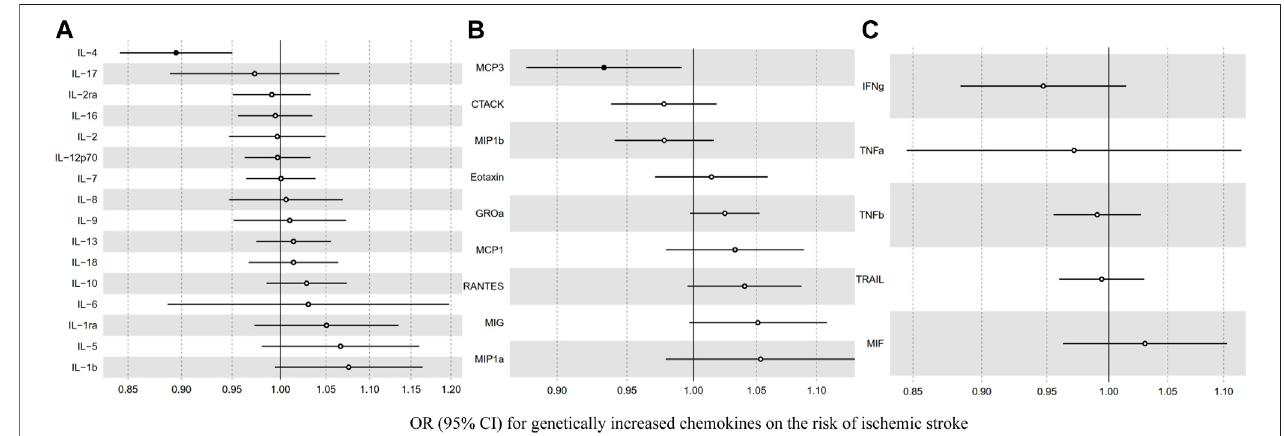
FIGURE 2 | The association between genetically determined in fl ammatory cytokines [ (A) interleukin (B) chemokine (C) other cytokines] and the risk of ischemic stroke.